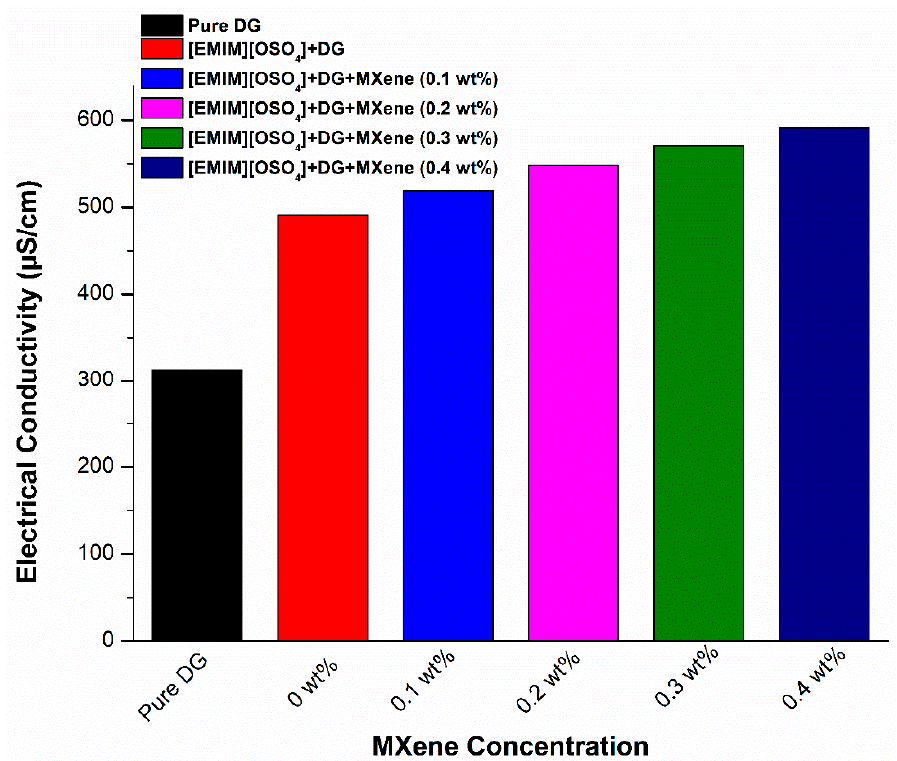
Figure 5. Electrical conductivity of the ionanofluids at different mass concentrations.